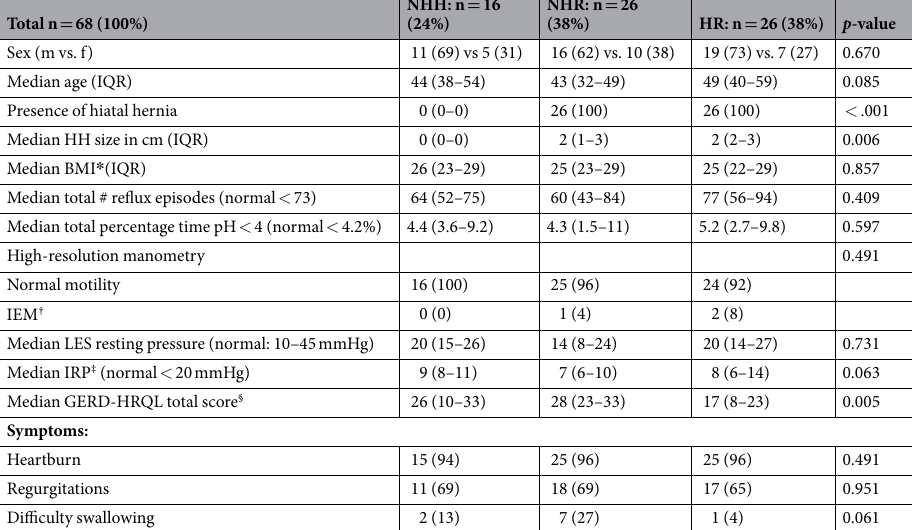
Median IRP ‡ (normal < 20 mmHg)